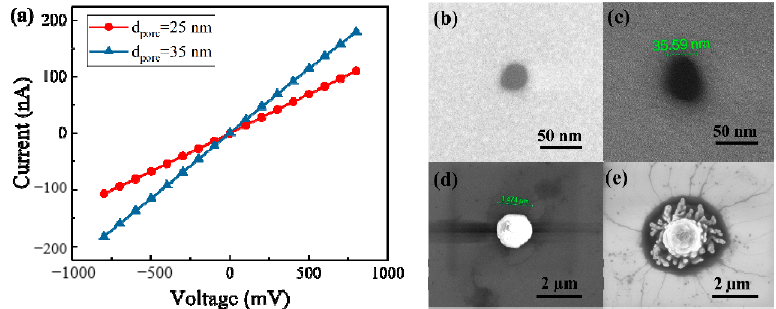
Figure 2. ( a ) Current–voltage curves for nanopores with diameters of 25 nm and 35 nm in 1M KCl solution; ( b ) and ( c ) SEM images of nanopores with diameters of approximately 26 nm and 36 nm; ( d ) SEM image of a polystyrene bead; ( e ) SEM image of a polystyrene bead after incubating with DNA–probe complexes. Micromachines 2020 , 11 , x